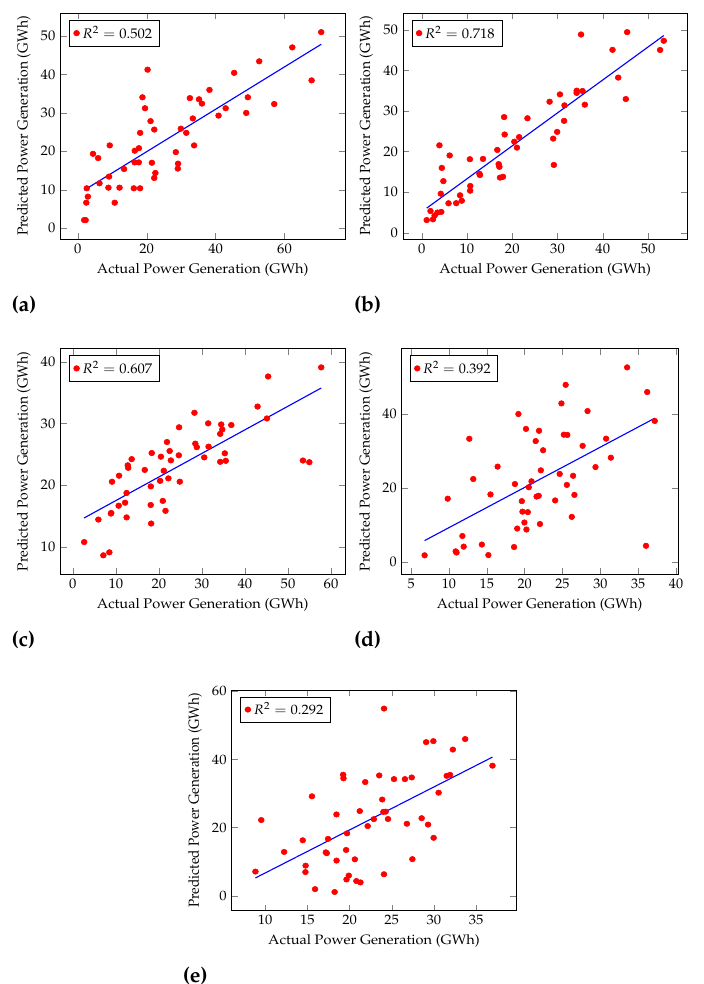
Figure 4. Coefficient of Determination ( R 2 ) of Rain Fall Test dataset for (a) KNN, (b) MLP, (c) ANFIS (d) PSO-ANFIS and (e) GA-ANFIS